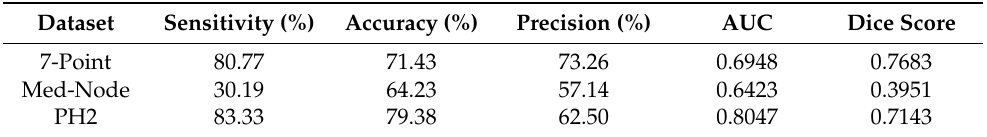
Table 2. Accuracy for 5-fold cross validation and kNN classifier for 2D Higuchi’s surface fractal de-